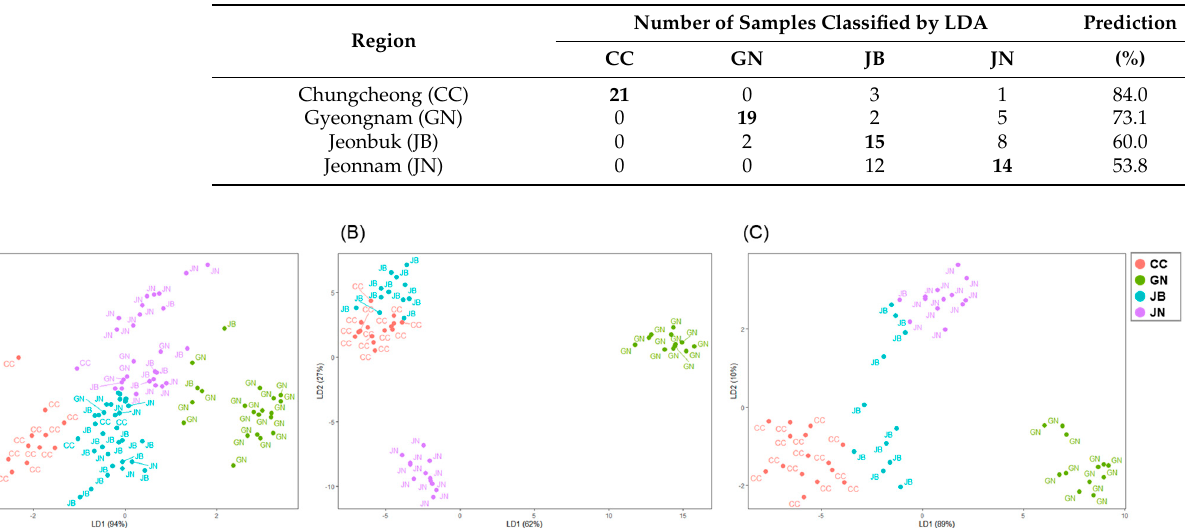
Figure 3. Linear discriminant analysis of Manila clams. ( A – C ) shows the LDA score plot of Ruditapes philippinarum collected from four different regions of Korea. The four colors represent samples from different regions, and the figure shows samples that were not well identified by the different colors at each site. In each case, stepwise application of LDA was performed for ( A ) dual-element isotopes, ( B ) fatty acid (FA) profiles, and ( C ) δ 13 C − FAs. Each color indicates Chungcheong (CC), Gyeongnam (GN), Jeonbuk (JB), and Jeonnam (JN), respectively.